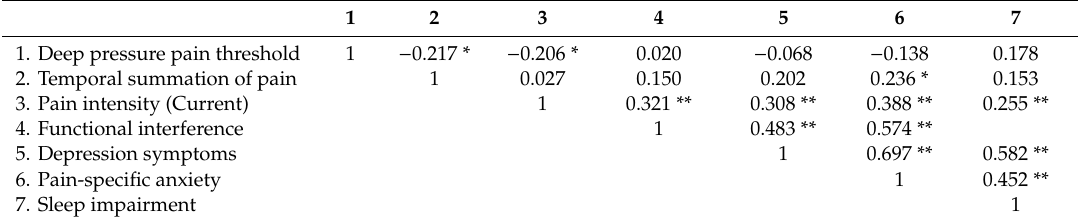
Table 6. Pearson correlations between key deep somatosensory test responses, pain outcomes and psychosocial measures.